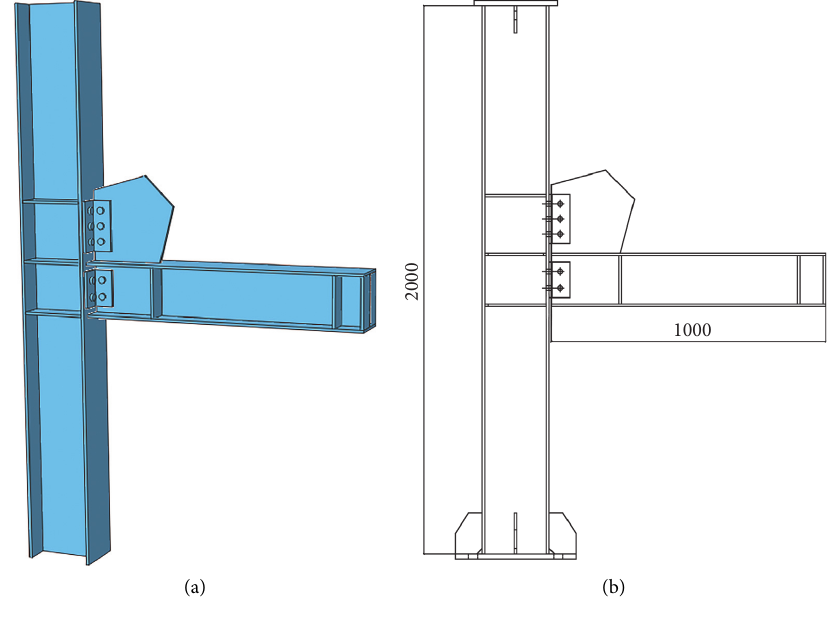
Figure 1: Specimen model (mm).